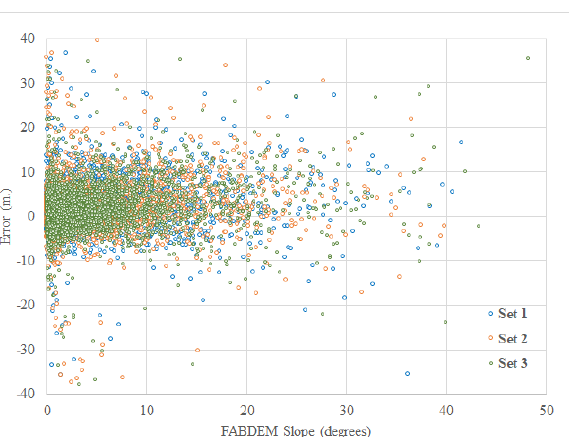
Figure 4. FABDEM errors plotted versus elevation.